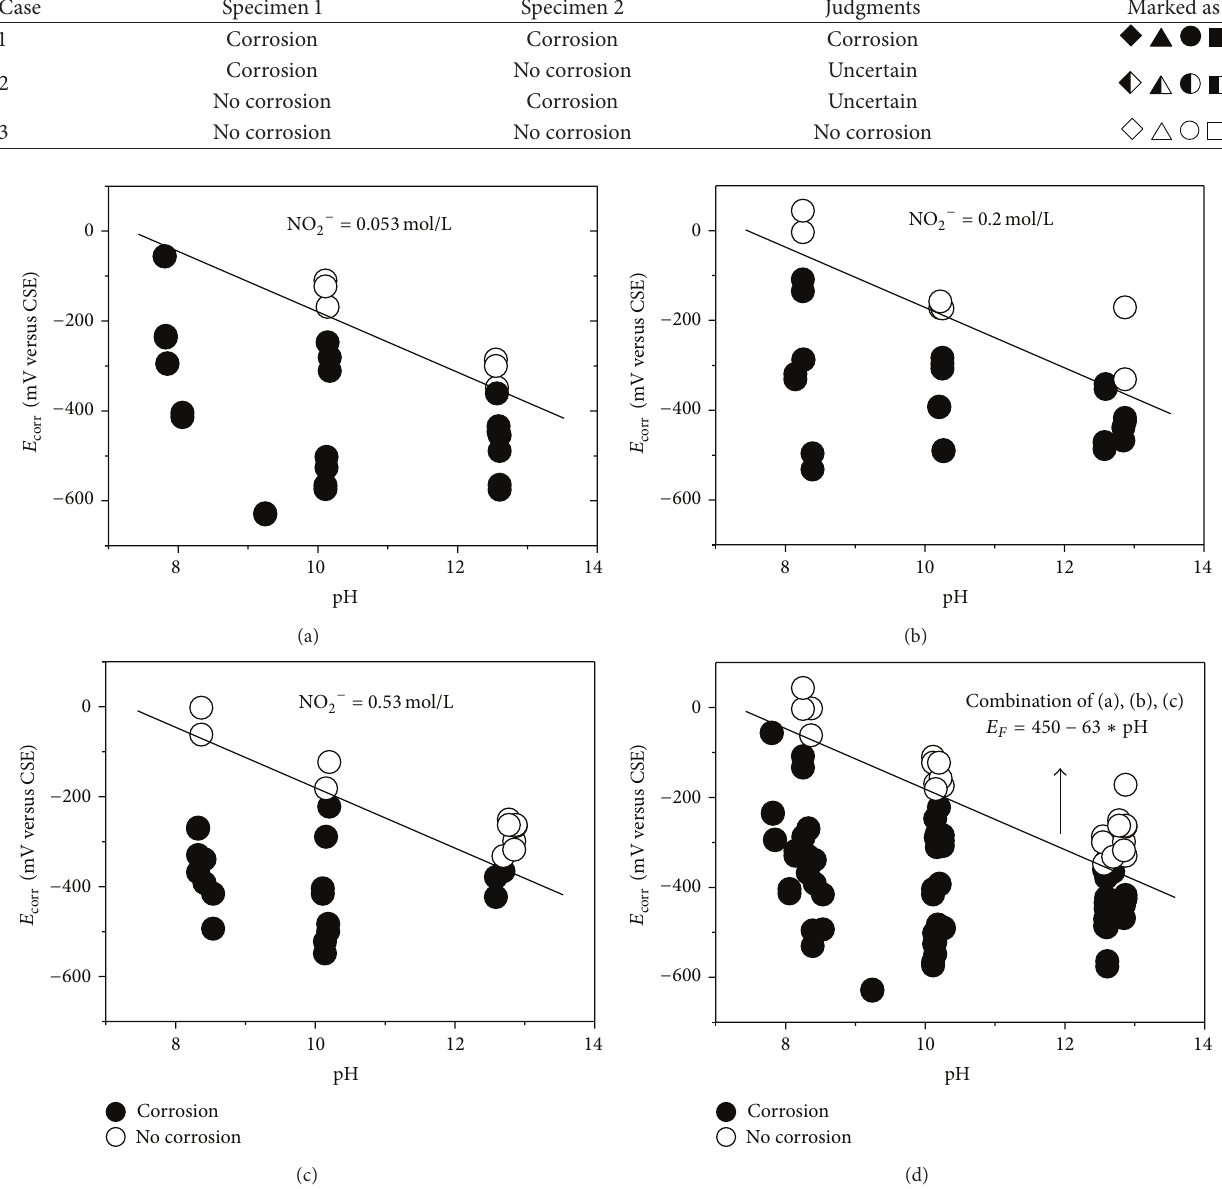
Figure 2: Relationship between 𝐸 𝐹 and pH for chloride-induced corrosion. (a) NO 2− = 0.053 mol/L, (b) NO 2− = 0.2 mol/L, (c) NO 2− = 0.53 mol/L, and (d) combination of (a), (b), and